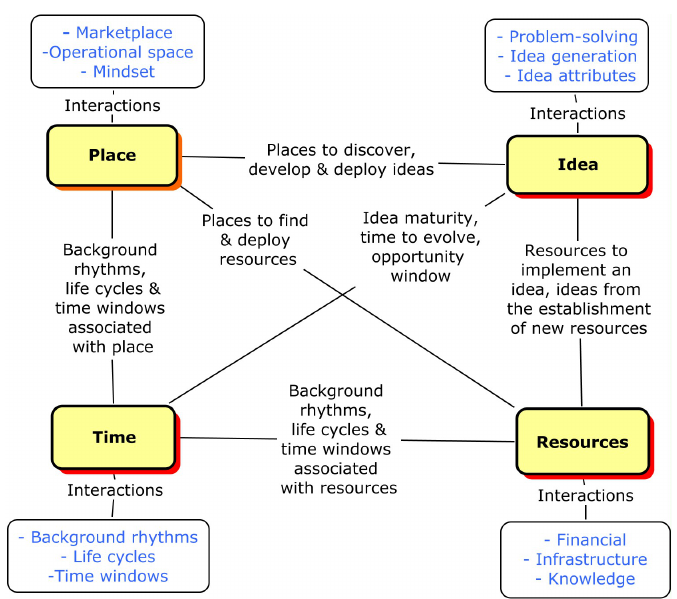
Fig. 1 . Contextual factors influencing timely decision-making drawing on the Ancient Greek notion of